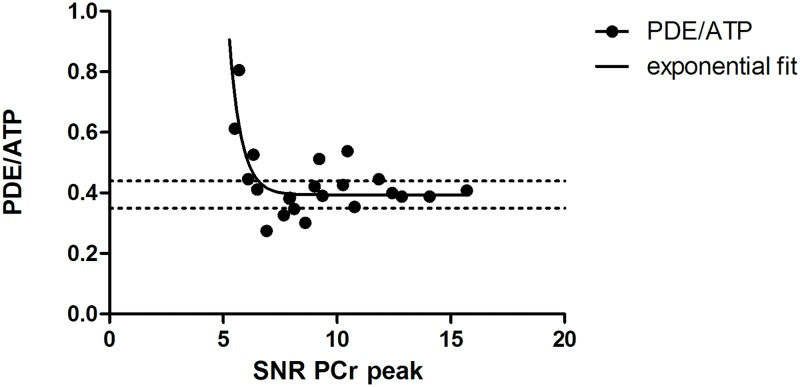
PDE/ATP as a function of SNR of the PCr peak.Each data point represents the PDE/ATP level assessed from the tibialis anterior muscle of the same subject under different SNR conditions. The black line represents the exponential fit and the dashed lines the 95% confidence interval of the estimated plateau.